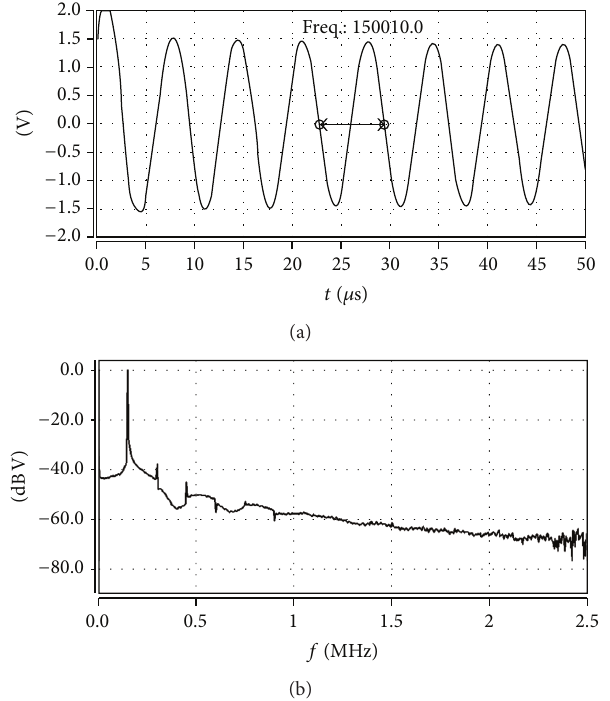
Figure 10: Simulation results for the circuit (Figure 4(b)) using CMOS OTRA (Figure 2): (a) output waveform and (b) correspond- ing frequency spectrum.